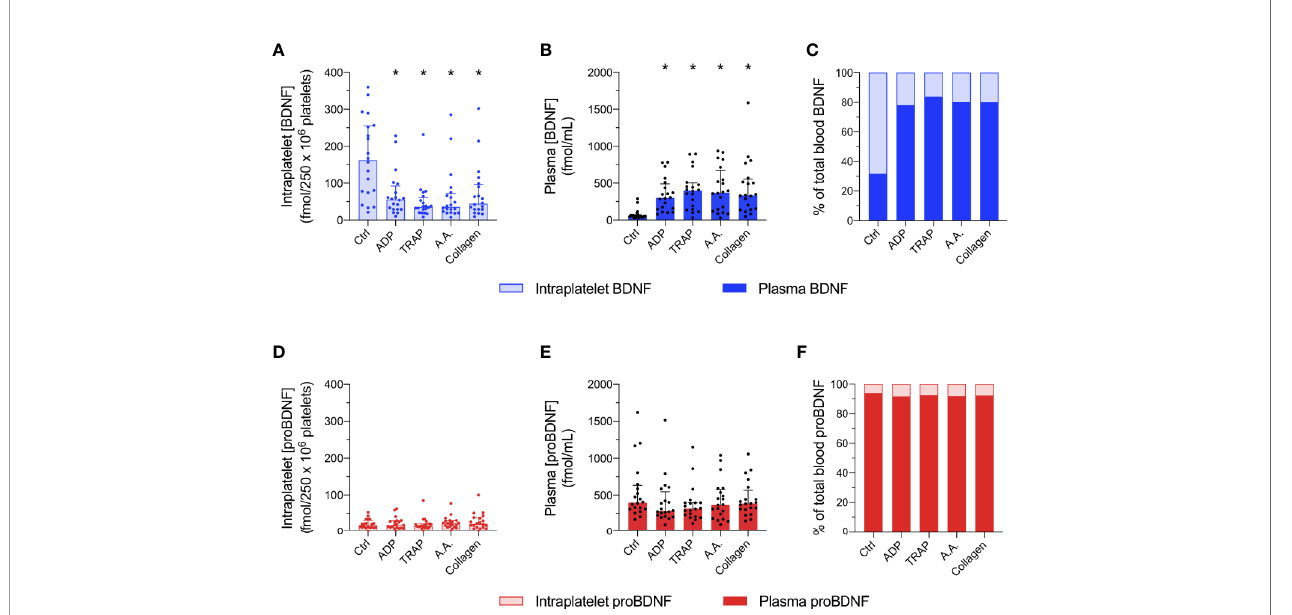
FIGURE 3 | Unlike BDNF, intraplatelet proBDNF is not released during platelet activation. Intraplatelet (A, D) and plasma (B, E) concentrations of BDNF and proBDNF following platelet activation by different agonists. Intraplatelet concentrations are normalized for 250 x 10 6 platelets. Proportion of BDNF (C) and proBDNF (F) in plasma vs . in platelets are expressed in percentage. Error bar represents IQR, *p < 0.05 vs . ctrl, n=20 participants (#1 to #20). Ctrl, control; ADP, adenosine diphosphate; TRAP, thrombin receptor-activating peptide; AA, arachidonic